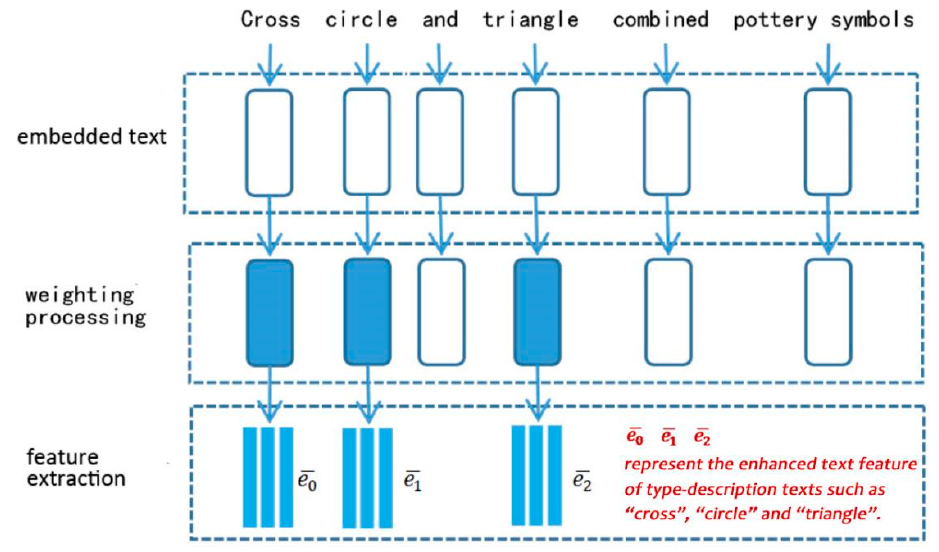
Figure 6. Text coding and feature vector